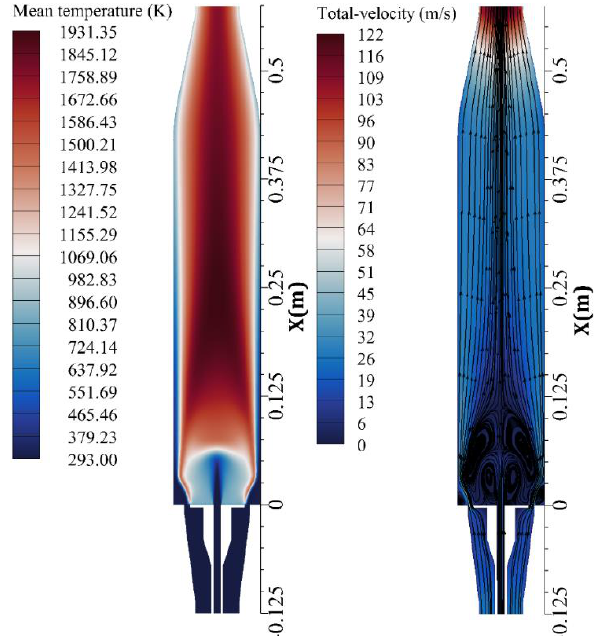
Figure 4. Present simulation profiles in comparison with experiment [1] along center line (Z = Y = 0): ( a ) Mean temperature, ( b ) X-velocity.